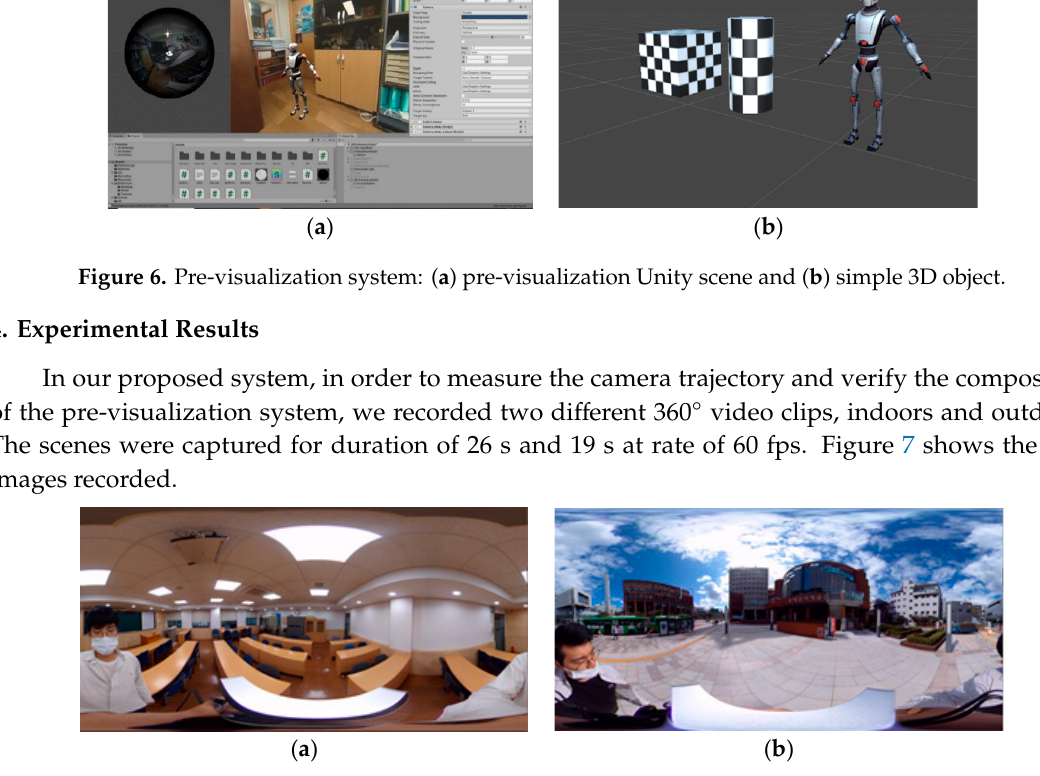
Figure 7. Experimental space for recording of 360° video: ( a ) indoor and ( b ) outdoor.